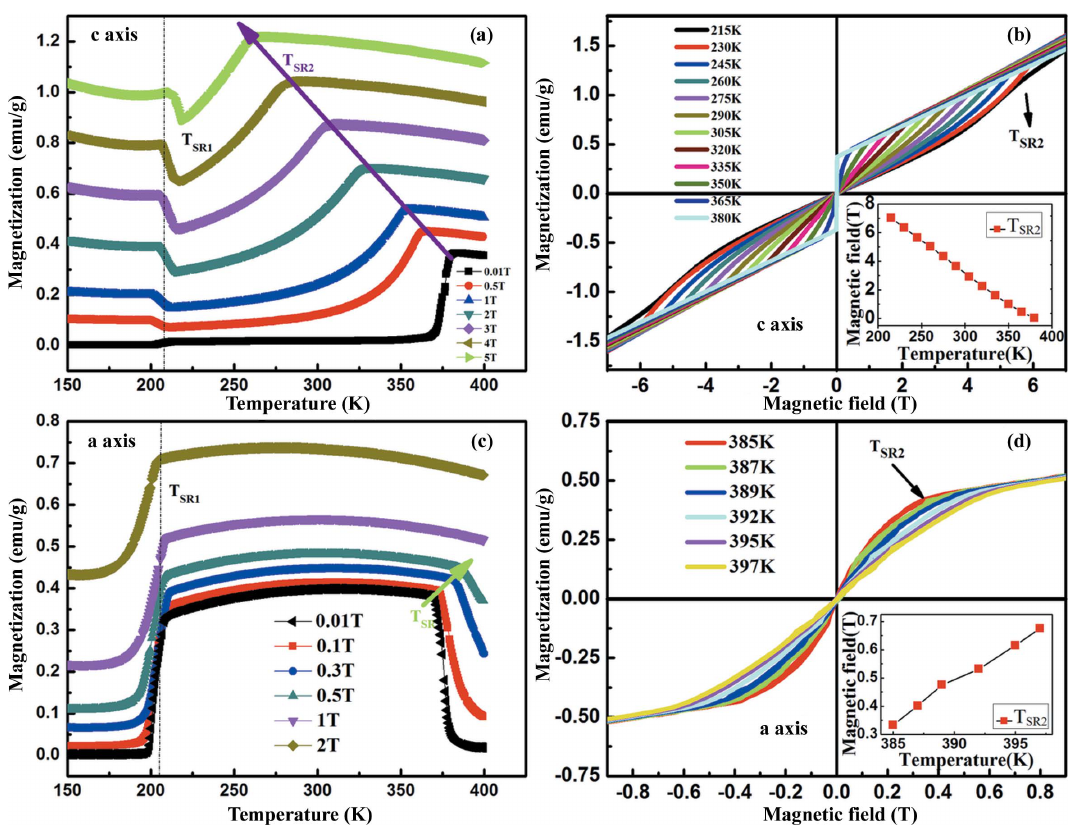
Figure 4 ( a ) M – T curves along the c axis at different magnetic fields from 0.01 to 5 T. ( b ) M – H curves along the c axis at different temperatures from 215 to 380 K. ( c ) M – T curves along the a axis at different magnetic fields from 0.01 to 2 T. ( d ) M – H curves along the a axis at different temperatures from 385 to 397 K. The insets in ( b ) and ( d ) show the linear temperature dependence of T SR2 along the c and a axes,